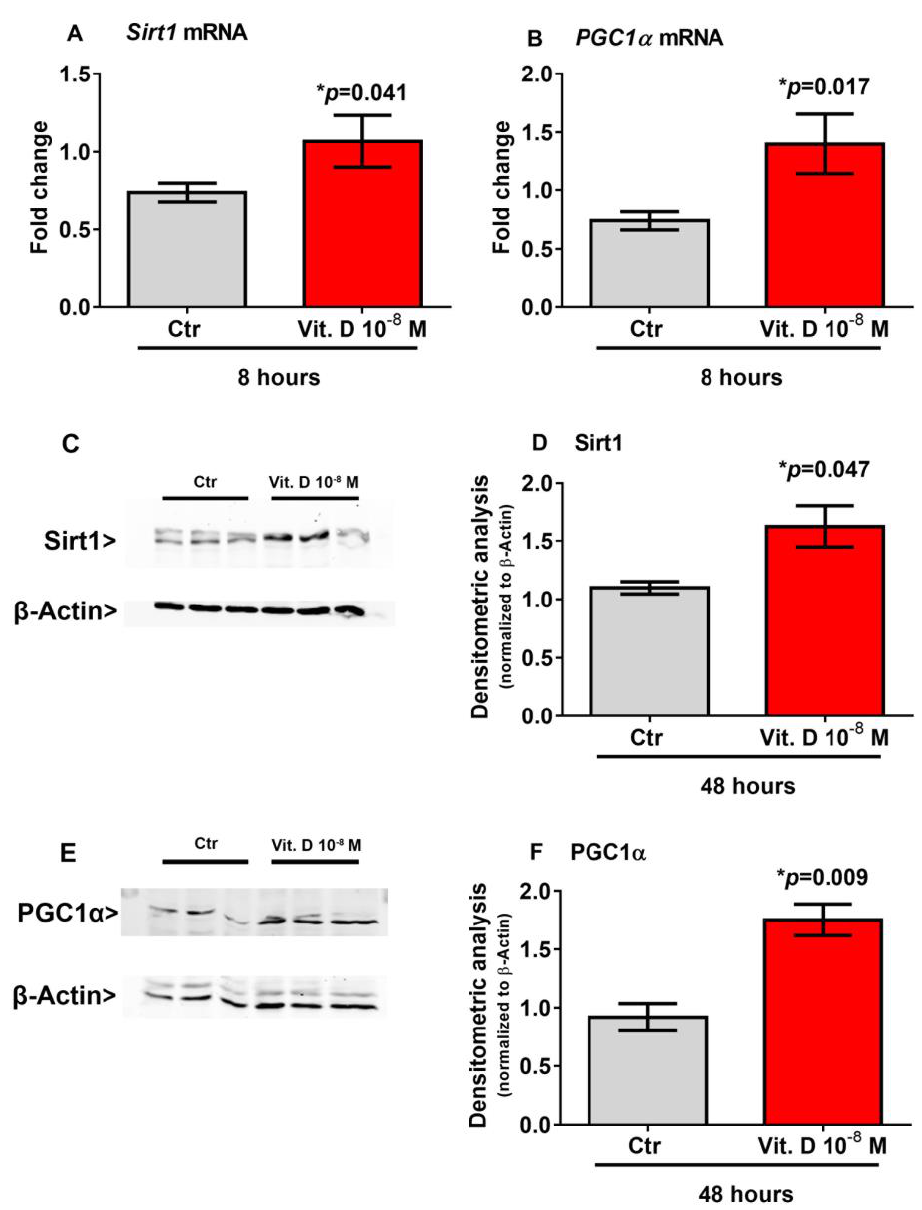
(Figure 3C,D) and the expression of Pgc1 α mRNA ( p = 0.017) (Figure 3B) and its protein level ( p = 0.009) (Figure 3E,F) in skeletal muscle cells.